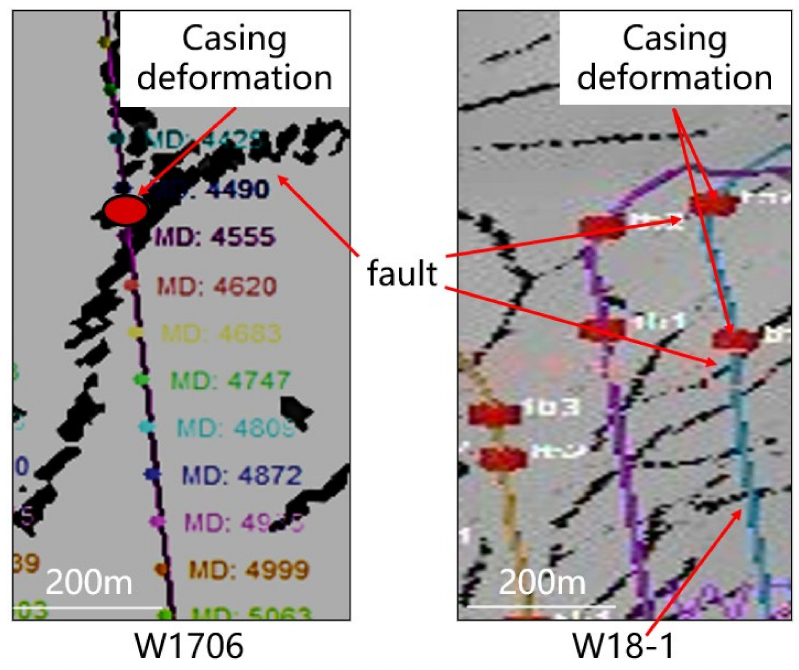
Figure 7. Fault distribution map and trajectories of w1706 and